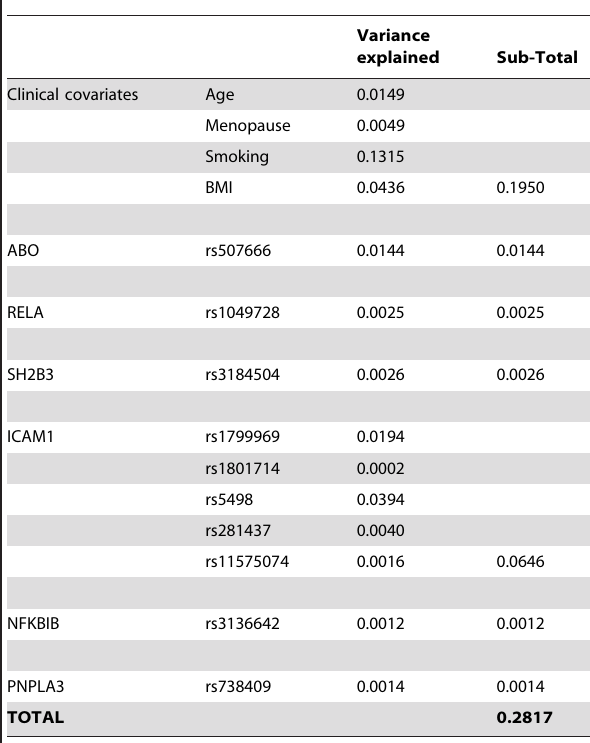
Table 4. Variance explained.